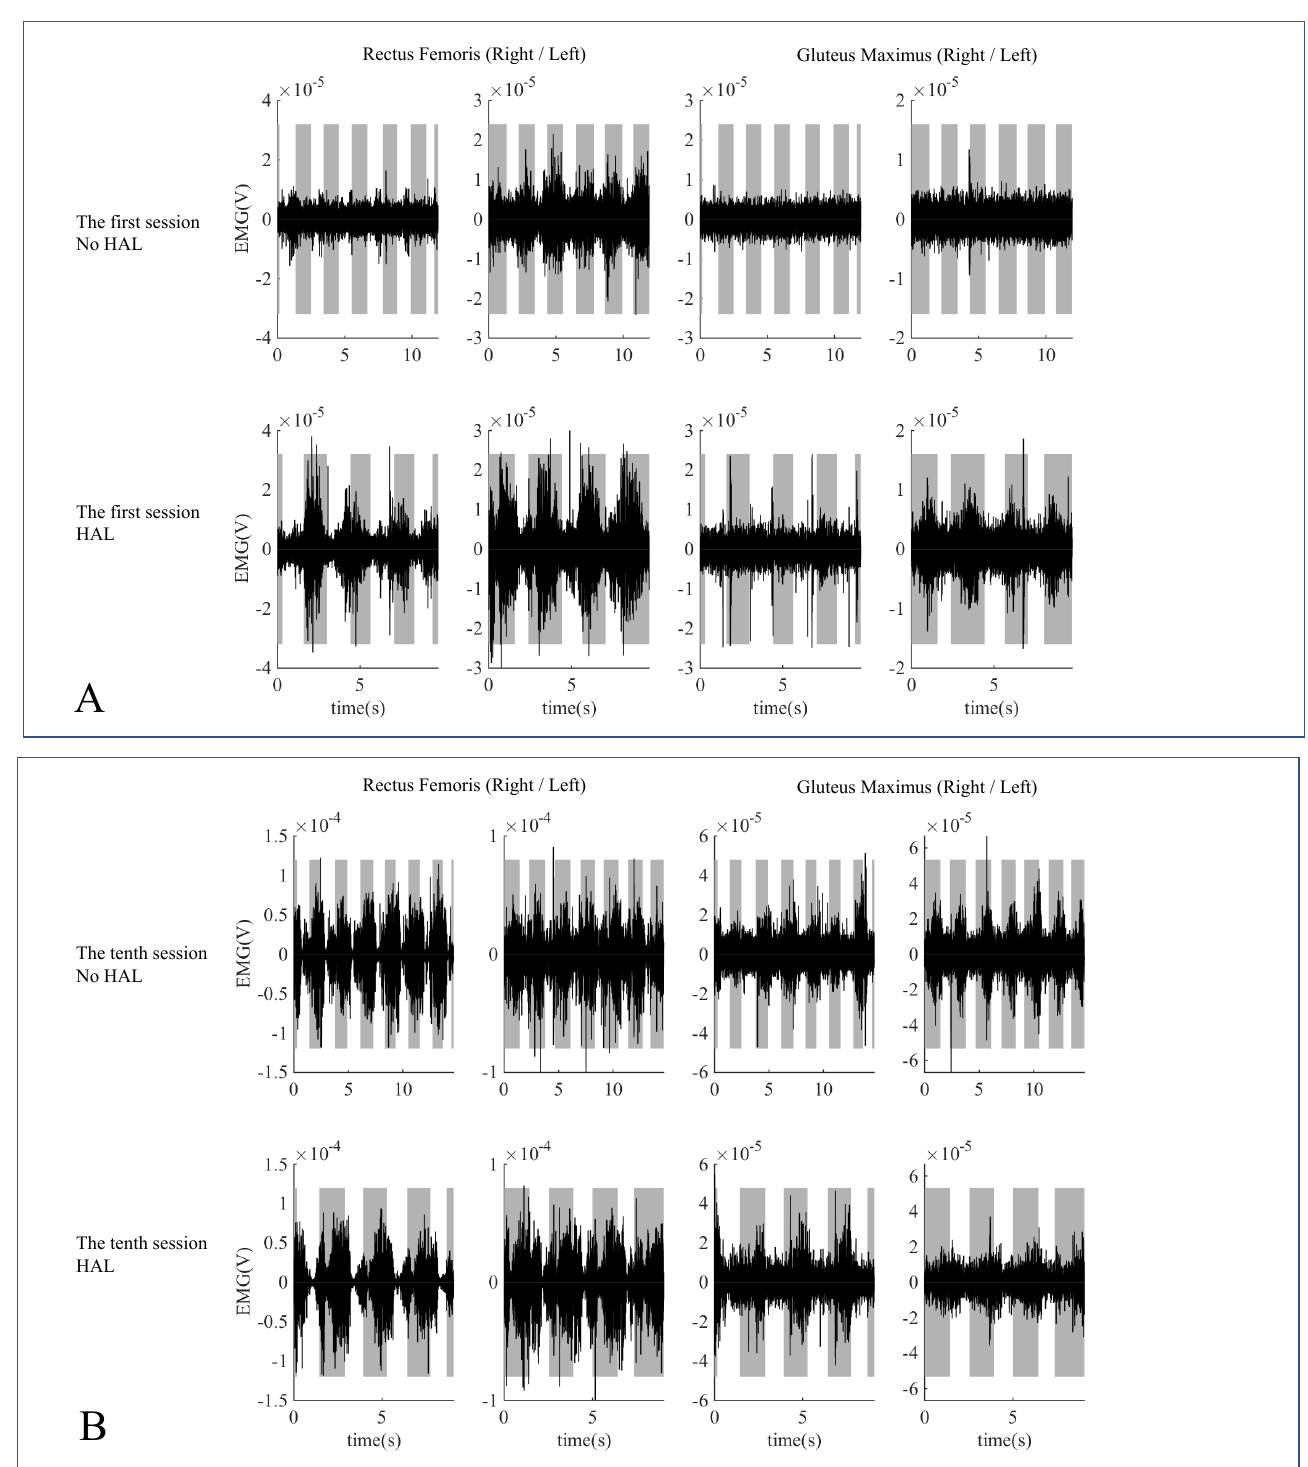
Figure 3. ( A ) Band-pass filtered EMG data of the rectus femoris and gluteus maximus muscles compared during the HAL training (with and without HAL) in the first session. ( B ) Band-pass filtered EMG data of the rectus femoris and gluteus maximus muscles compared during the HAL training (with and without HAL) in the tenth